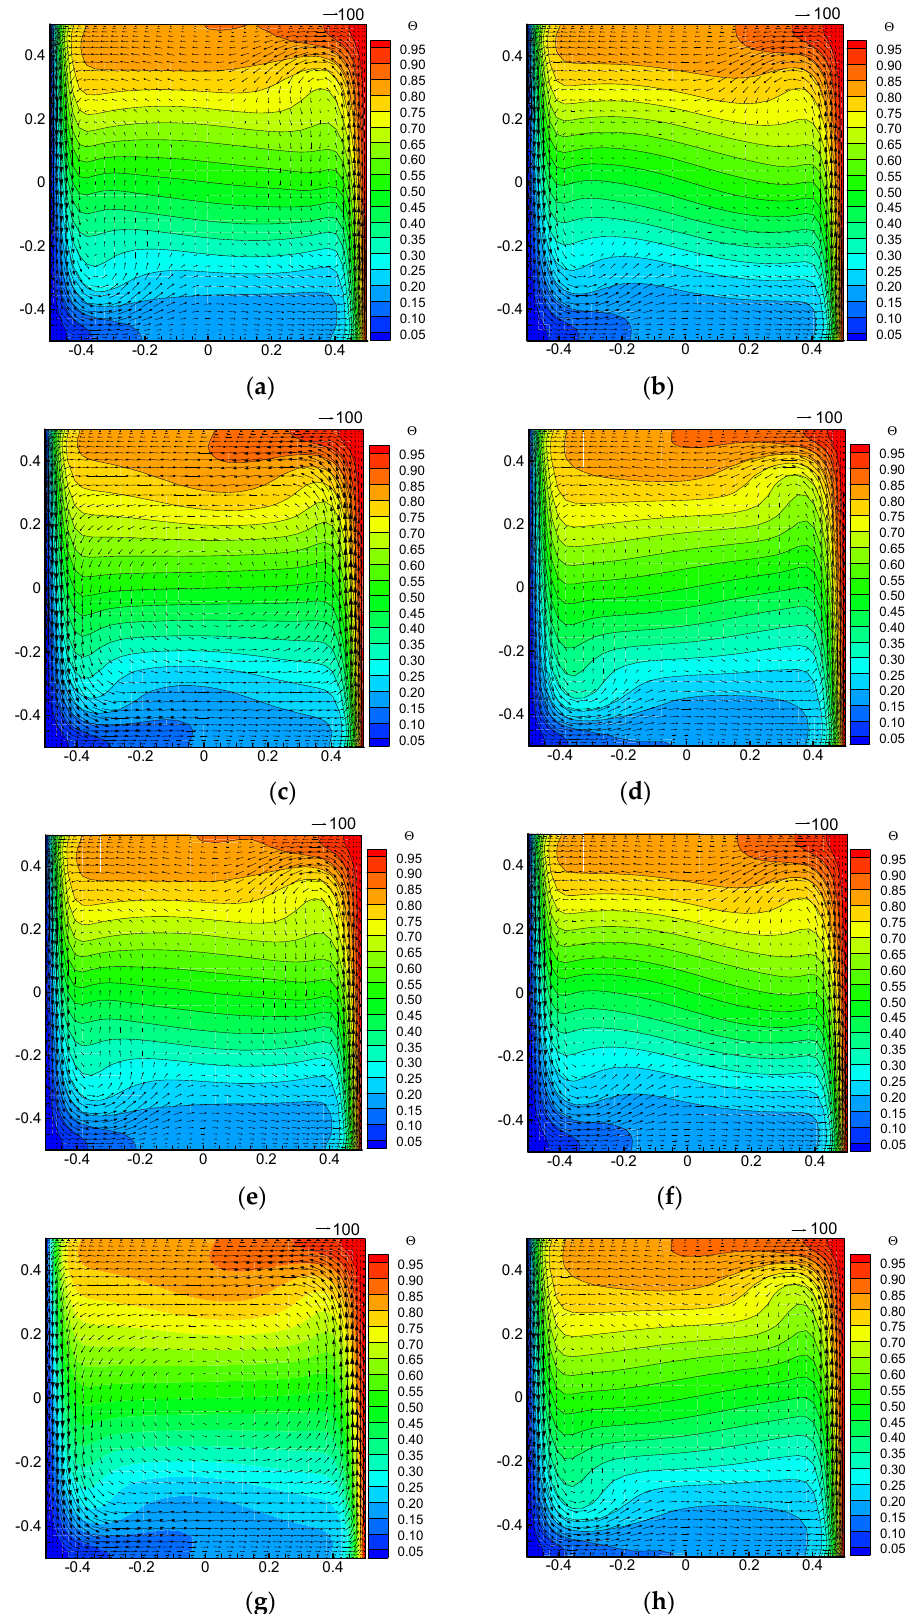
Figure 12. Temperature field evolution at x-o-z plane for Case 4: ( a ) ϕ = 0 (+) ; ( b ) ϕ = ϕ m /2 (+) ; ( c ) ϕ = ϕ m ; ( d ) ϕ = ϕ m /2 ( − ) ; ( e ) ϕ = 0 ( − ) ; ( f ) ϕ = − ϕ m /2 ( − ) ; ( g ) ϕ = − ϕ m ; ( h ) ϕ = − ϕ m /2 (+)